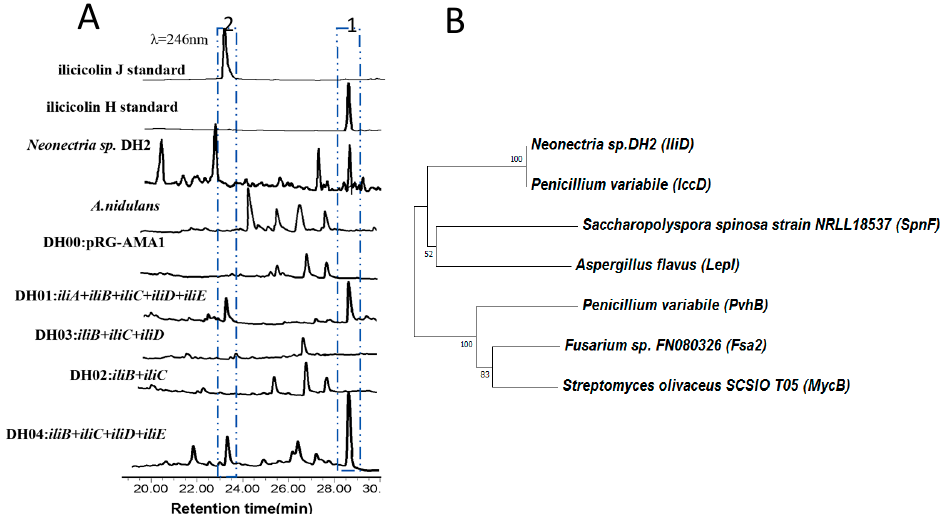
Figure 3. ( A ) HPLC trace of the metabolites of A. nidulans strains and Neonectria sp. DH2. The peak at 23 min is ilicicolin J and the peak at 29 min is ilicicolin H. ( B ) Phylogenetic analysis of iliD and related pericyclases.